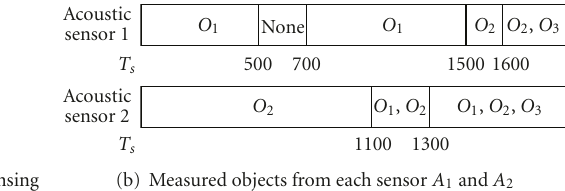
Figure 18: Measured objects over